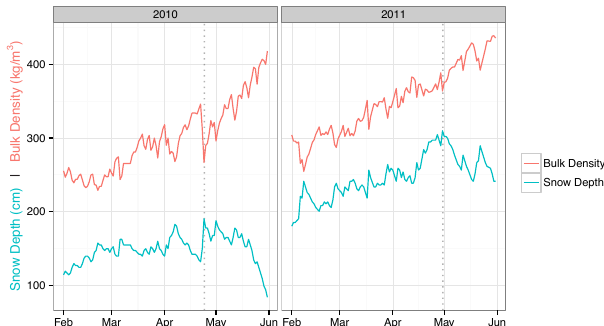
Fig. 1. Data from the Lake Irene SNOTEL site in northern Colorado. Depth and density are negatively correlated at short timescales (10 days). The accumulation and ablation phases are distinguished by the vertical, dashed line. During the accumula- tion phase, depth and density are positively correlated at longer timescales (months). During ablation, the variables are negatively correlated at long